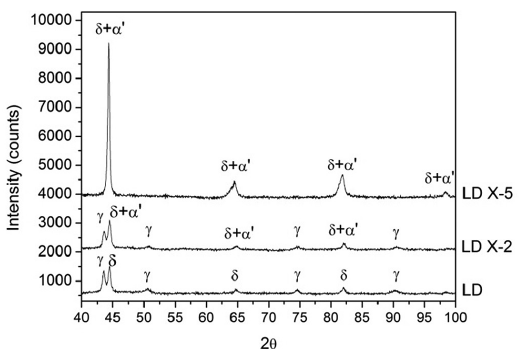
Figure 4. X-ray diffraction patterns of specimens LD ST, LD X-2 and LD X-5.